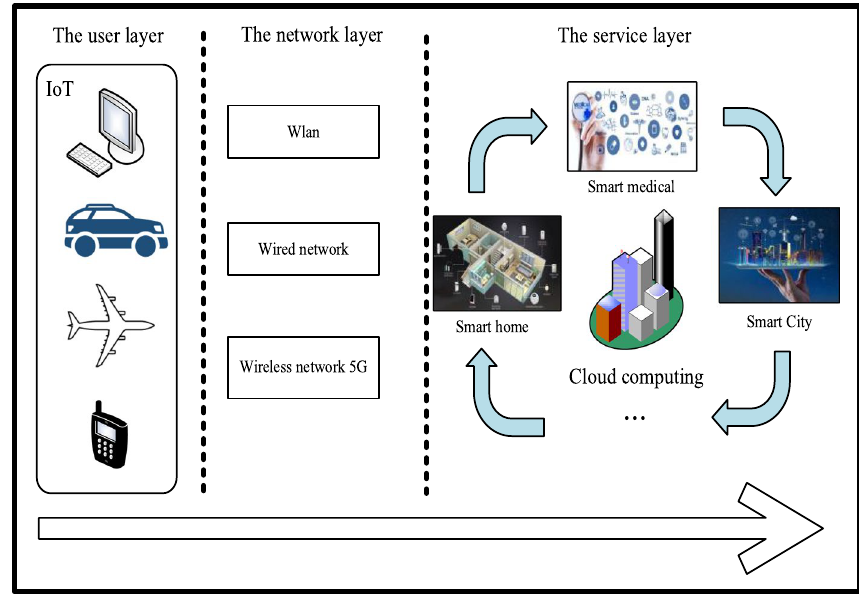
Fig. 2 Infrastructure of 5G Internet of